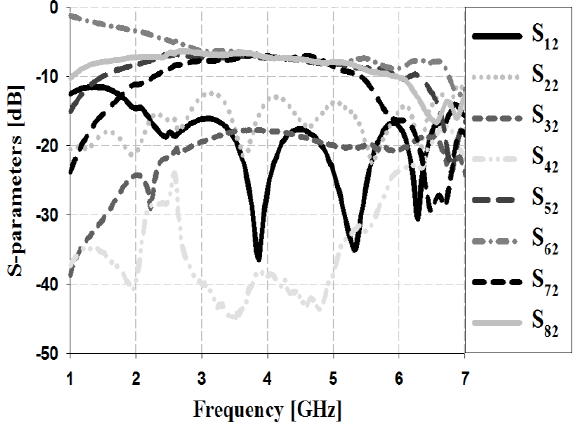
Sensors 2019 , 19 , x FOR PEER REVIEW Figure 16. Measurement analysis of S-parameters for input Port 1. Figure 16. Measurement analysis of S-parameters for input Port 1.